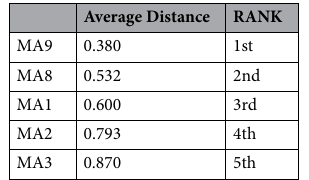
Table 5. SPOTIS average distances from the ideal solution (5 alternatives).